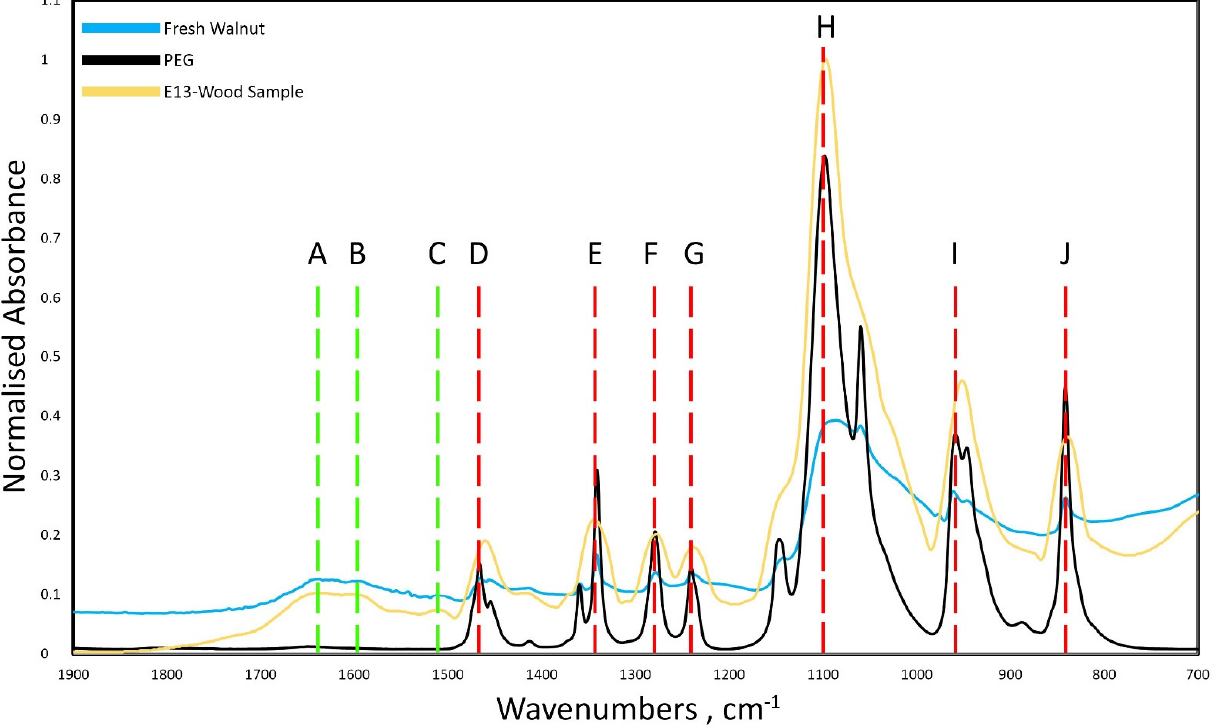
Figure 7. FTIR spectra collected for fresh walnut, PEG, and the E13 archaeological wood sample.